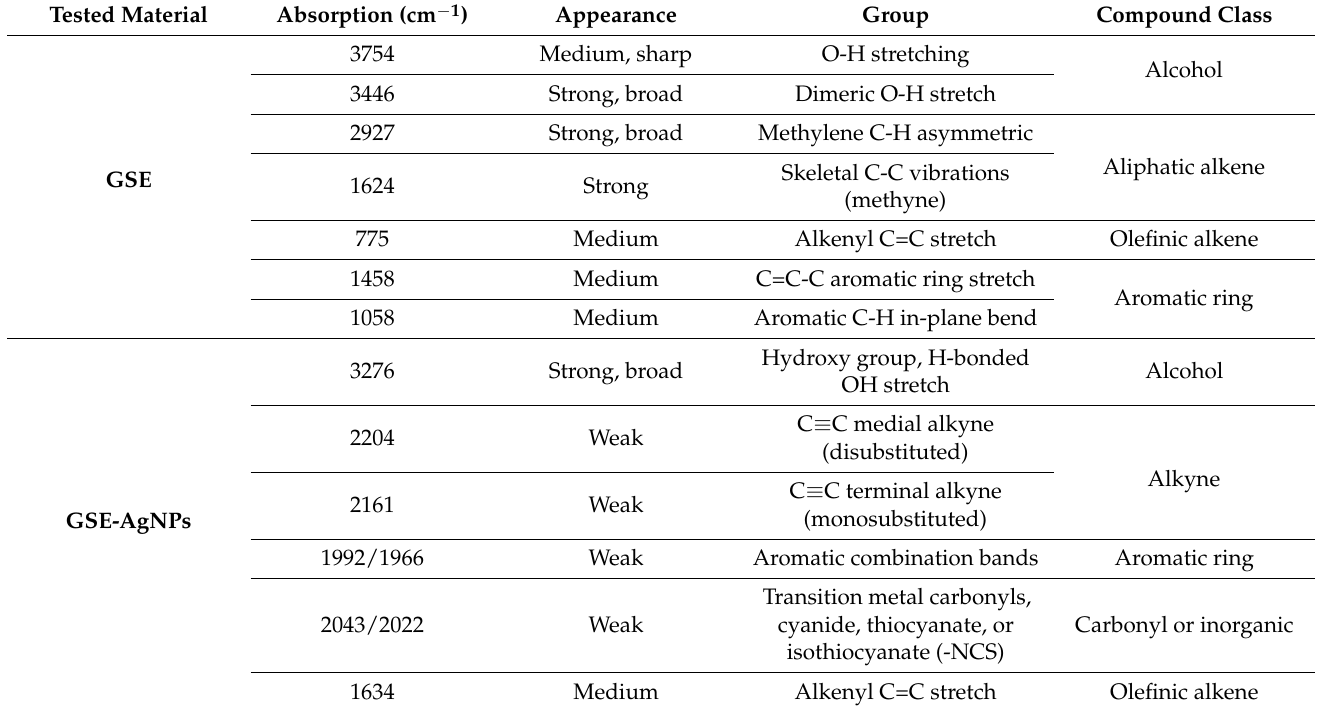
Figure 5. FTIR analysis. Nicolet 6700 FTIR Spectrometer was used to identify the functional groups in ( A ) GSE and ( B ) GSE-AgNPs at the range of 500–4000 cm − 1 . Table 1. The FTIR analysis of the functional groups in the GSE and GSE-AgNPs.